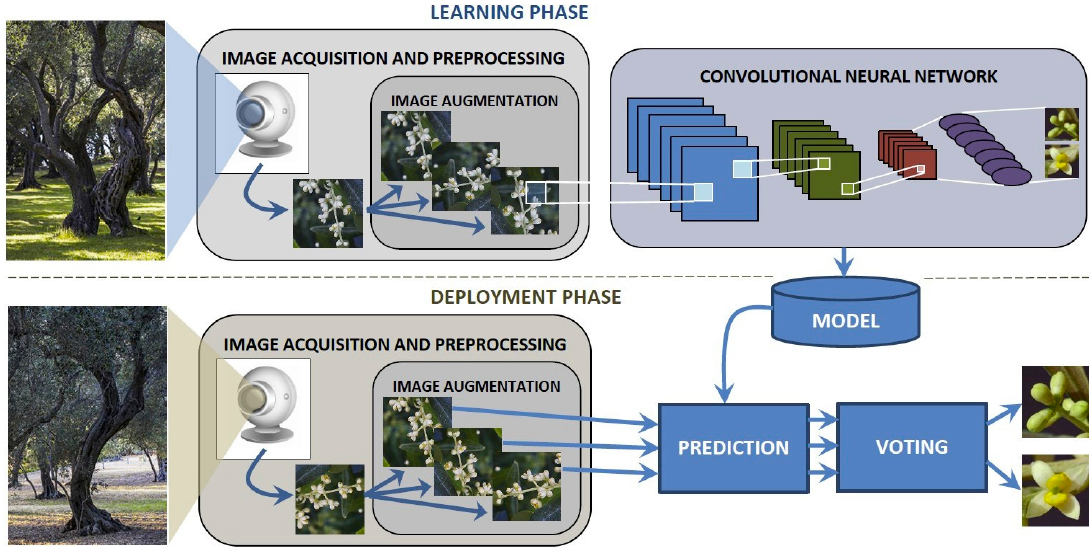
Figure 9. Neural network architecture for phenophases detection.